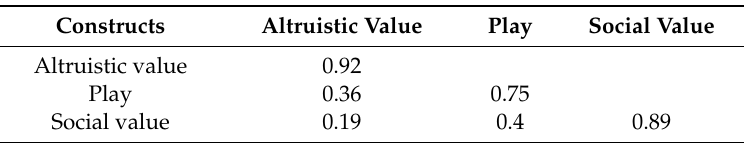
Table 5. Fornell-Larcker